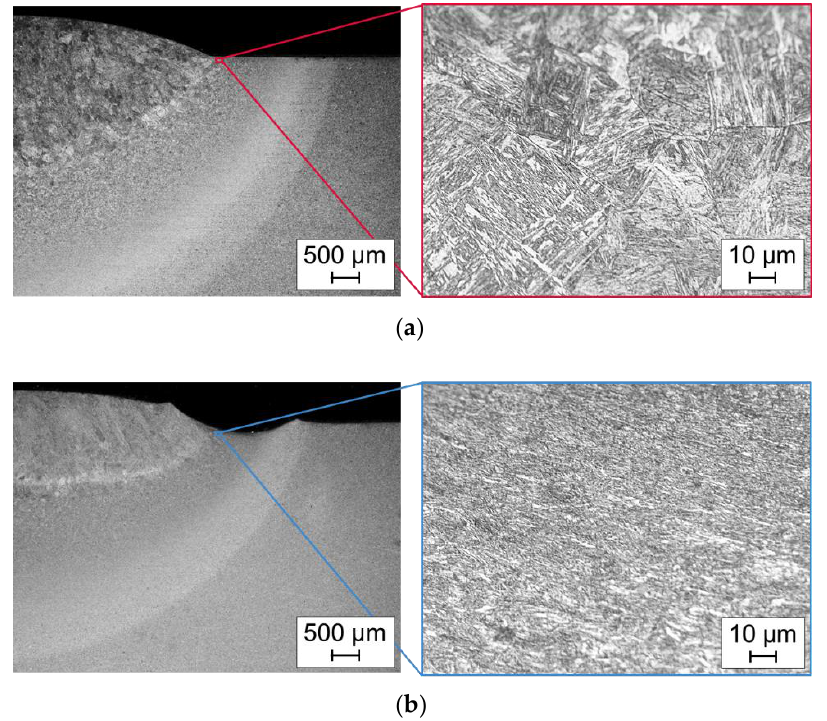
Figure 10. Microscopic image near the weld toe of: ( a ) W; and ( b ) WN.